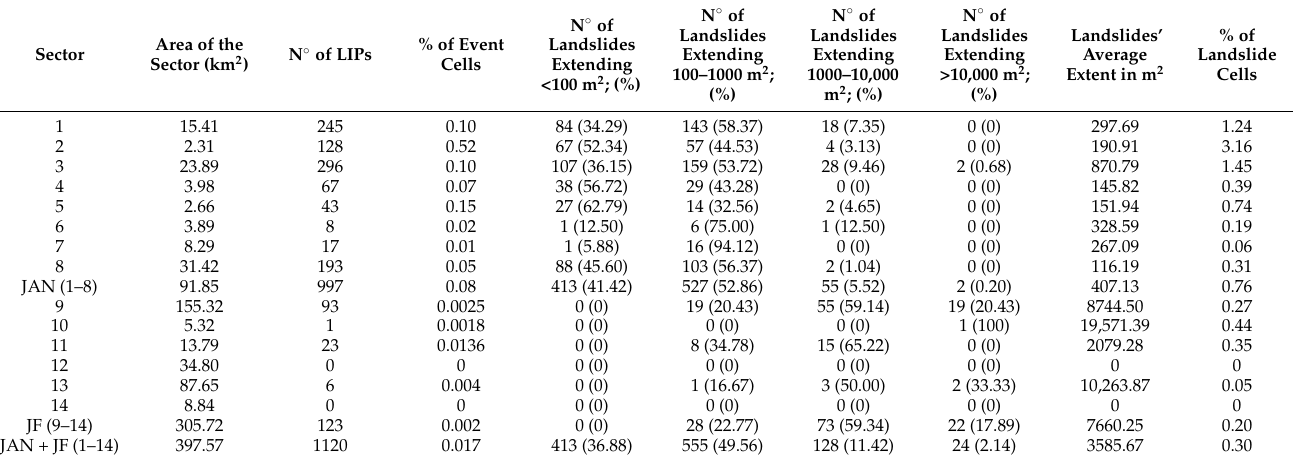
Table 6. Amounts and characteristics of the landslides triggered by the January earthquake in sectors 1 to 14.